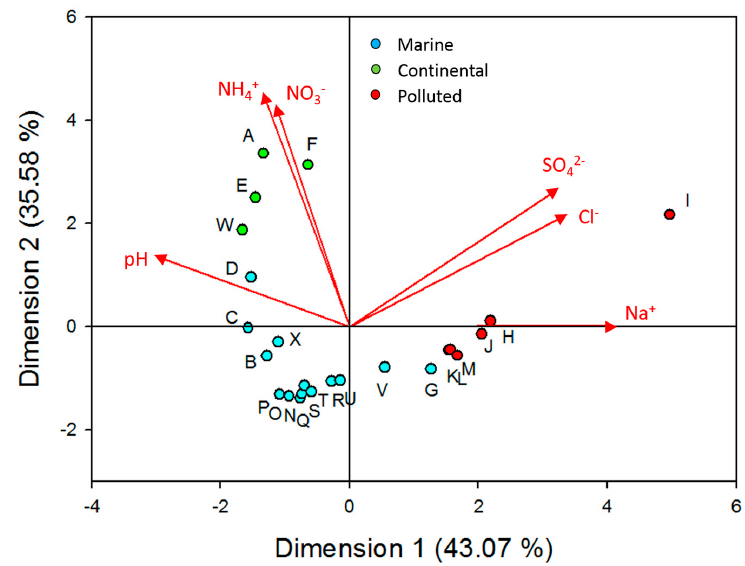
Figure 3. Bi-plot resulting from the PCA (principal component analysis) (PCA2) and detailing: with circles, the scores of the samples presented in this work (marine in light blue, continental in green, polluted in red); with the red vectors, the loadings of the six experimental variables pH, Cl − , NO 3 − , SO 42 − , Na + and NH 4+ ; (PCA is performed using µM unit concentrations and automatic normalization of the data).